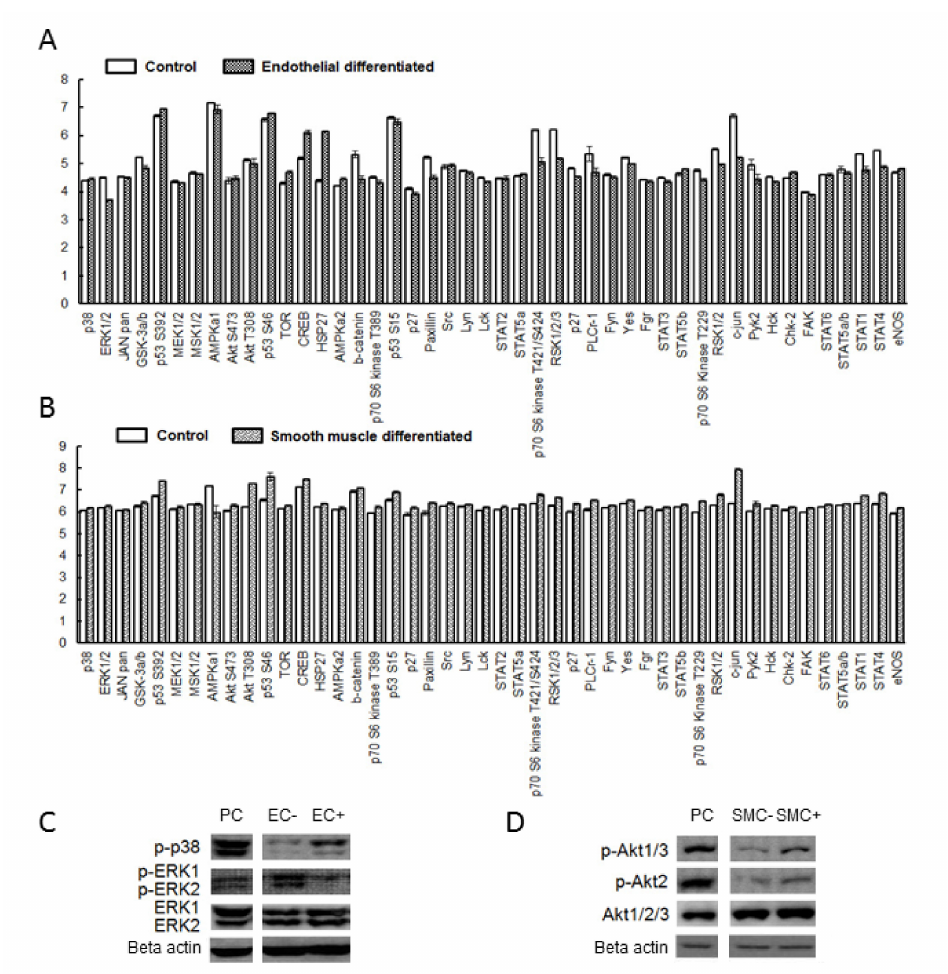
Figure 6. The possible underlying signaling transduction pathways in endothelial and smooth muscle cell di ff erentiation. Human phosphor-kinase array was utilized to evaluate 46 kinase phosphorylation sites after endothelial ( A ) and smooth muscle ( B ) di ff erentiation. ERK1 / 2, β -catenin, STAT1, RSK1 / 2 and c-jun were inhibited while TOR and HSP27 were activated after endothelial di ff erentiation (A). p53, Akt, paxillin and c-jun were activated while AMPK α 1 was inhibited after smooth muscle di ff erentiation (B). In addition, Western blot analysis confirmed that p38 was activated while ERK1 / 2 was inhibited in endothelial di ff erentiation ( C ); Akt was activated in smooth muscle cell di ff erentiation ( D